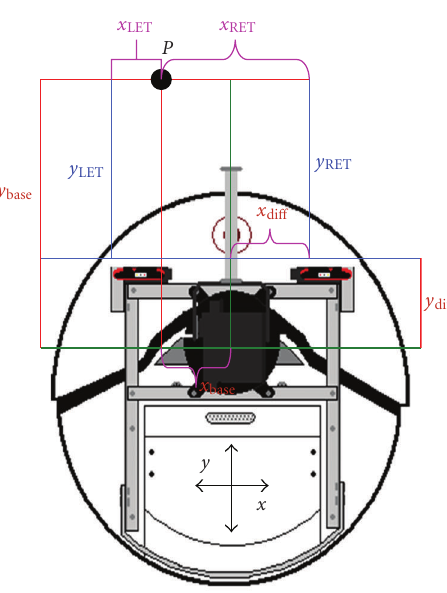
Figure 9: Object Cartesian coordinates.